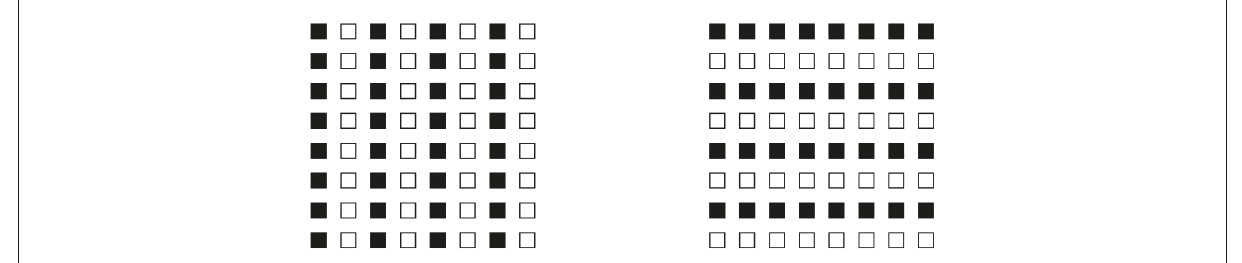
FIGURE2 By zooming on the 3 × 3 sub-matrixes of small squares placed at the top right side of the whole groupings of squares, the columns appear to induce an upwards elongation of the sub-matrix now perceived as a vertical rectangle. The rows, on the contrary, elicit the perception of a wide horizontal rectangle.